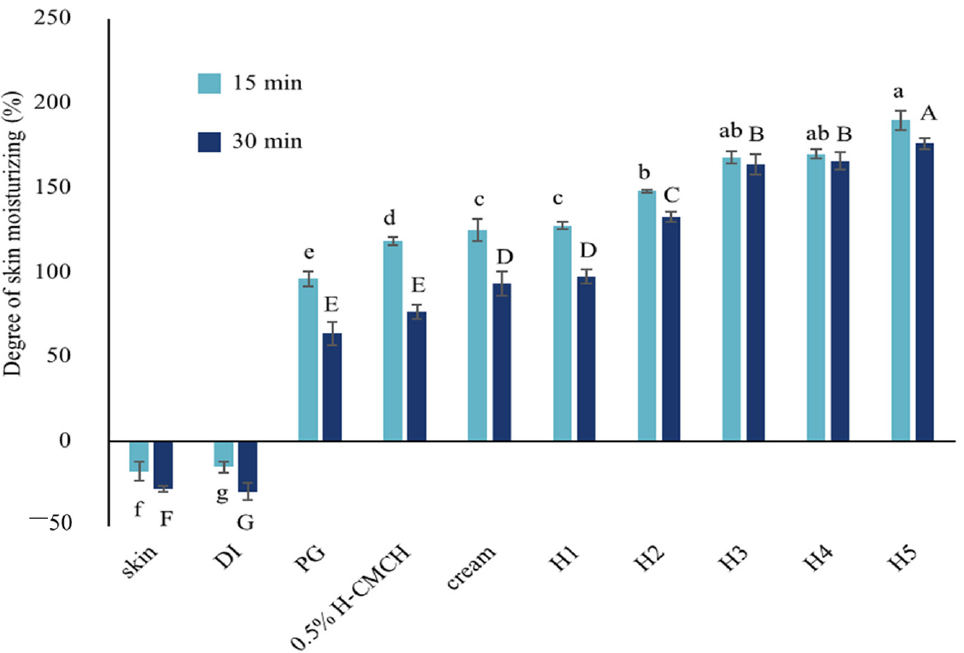
Figure 1. DM (%) as affected by time (15 and 30 min) and different treatments (skin, DI, PG, H1, H2, H3, H4, and H5) on pig skin. Different lowercase letters (a,b,c...) indicate significant differences between solutions at 15 min and different uppercase letters (A,B,C...) indicate significant differences between solutions at 30 min.